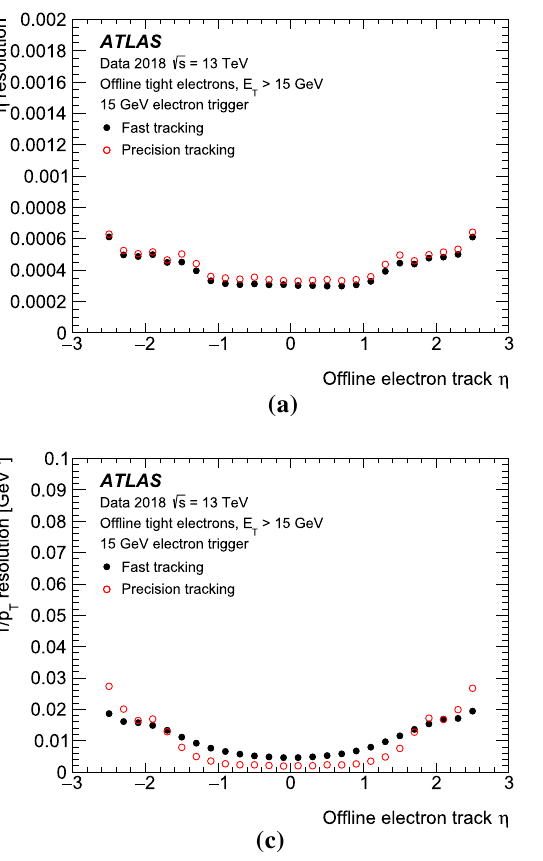
selected by the E T > 15GeV electron requirement from the dilep- ton support triggers, for both the fast tracking and precision tracking